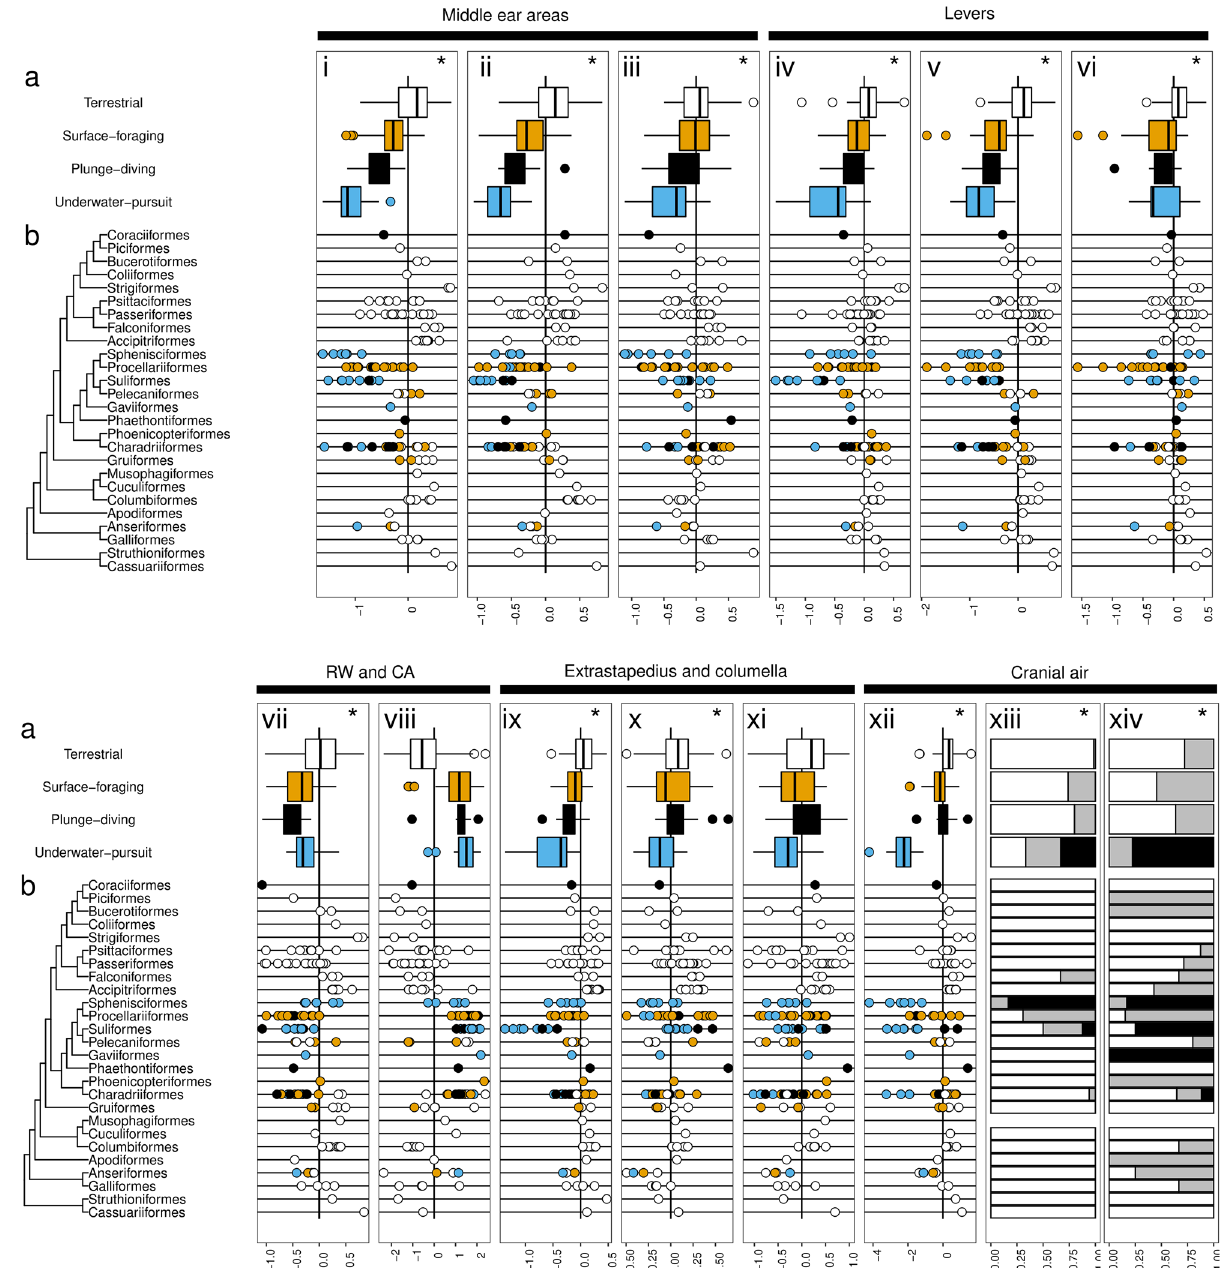
Figure 4. Relative sizes of auditory structures, adjusted for head mass and phylogenetic relatedness and grouped by ecological group ( a ) and order ( b ). Data are residuals of univariate PGLS regressions relating head mass with each respective ear measure, both as log-transformed variables. Negative values (left of the black vertical lines) indicate smaller values than expected for the bird’s head mass, and positive values indicating greater values than expected. Box plots show the distributions of residuals by ecological group in ( a ) and individual data points represent different species in ( b ). Colors indicate ecological groups (white for terrestrial, orange for surface-foraging, black for plunge-diving, blue for underwater-pursuit). (i) tympanic membrane area, (ii) columella footplate area, (iii) tympanic membrane-to-columella footplate area ratio, (iv) columella offset from center of tympanic membrane, (v) umbo height, (vi) tympanic membrane angle, (vii) round window area (RW), (viii) cochlear aqueduct area (CA), (ix) extrastapedius length, (x) columella length, (xi) columella volume (xii) cranial air volume. An asterisk is present if the best-supported model for that ear measure included ecological group. In panels xiii and xiv, bar plots indicate the proportions for three levels of cranial air connectivity for the interaural canal and interbullar passage, respectively (white for air-filled connection, grey for connection present but filled with soft tissue, black signifies no pneumatic opening in the